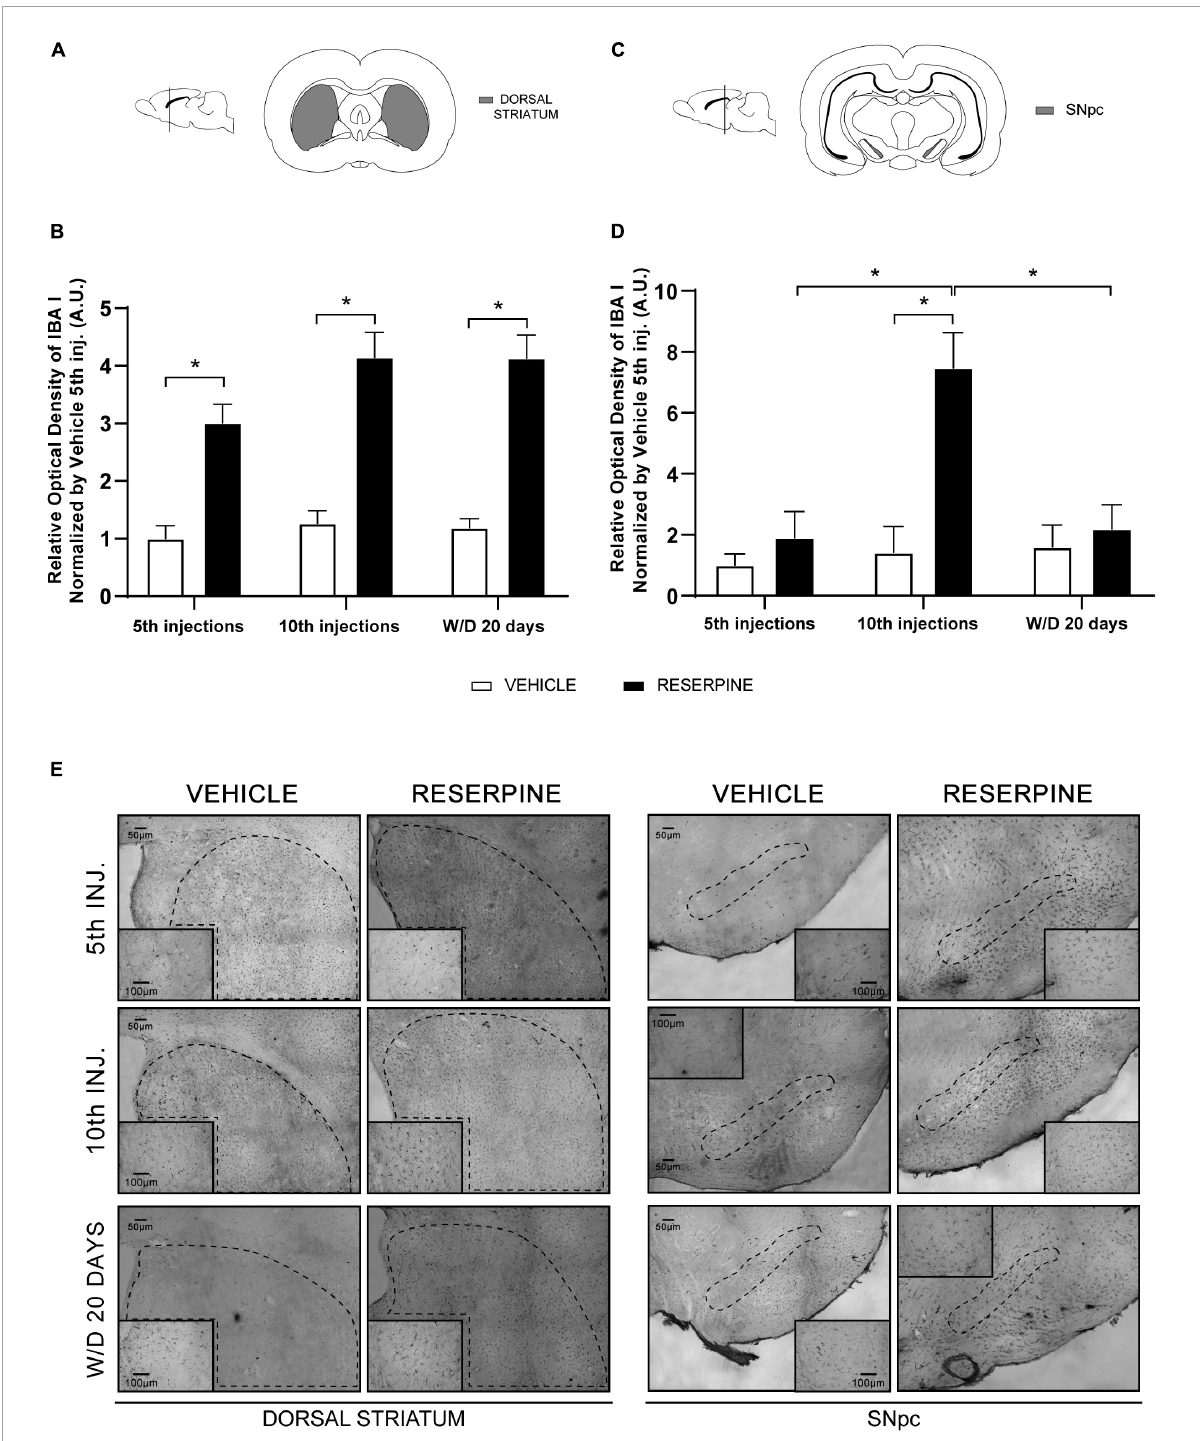
FIGURE5 Coronal slice scheme of Dorsal Striatum (A) and SNpc (C) ; effects of repeated administration of 0.1 mg/kg reserpine ( n = 5) on relative optical density (ROI) for IBA 1 staining in Dorsal Striatum (B) and SNpc (D) ; and representative photomicrographs in coronal sections (E) . Data are shown as mean + SEM, * p < 0.05 comparing Reserpine and Vehicle groups (ANOVA followed by Sidak’s test). SNpc: scale bar 200 µ m; magnification 4x in overview images and scale bar of 100 µ m further magnified insets (10x). Dorsal Striatum: scale bar 300 µ m; magnification 2x in overview images and scale bar of 200 µ m further magnified insets